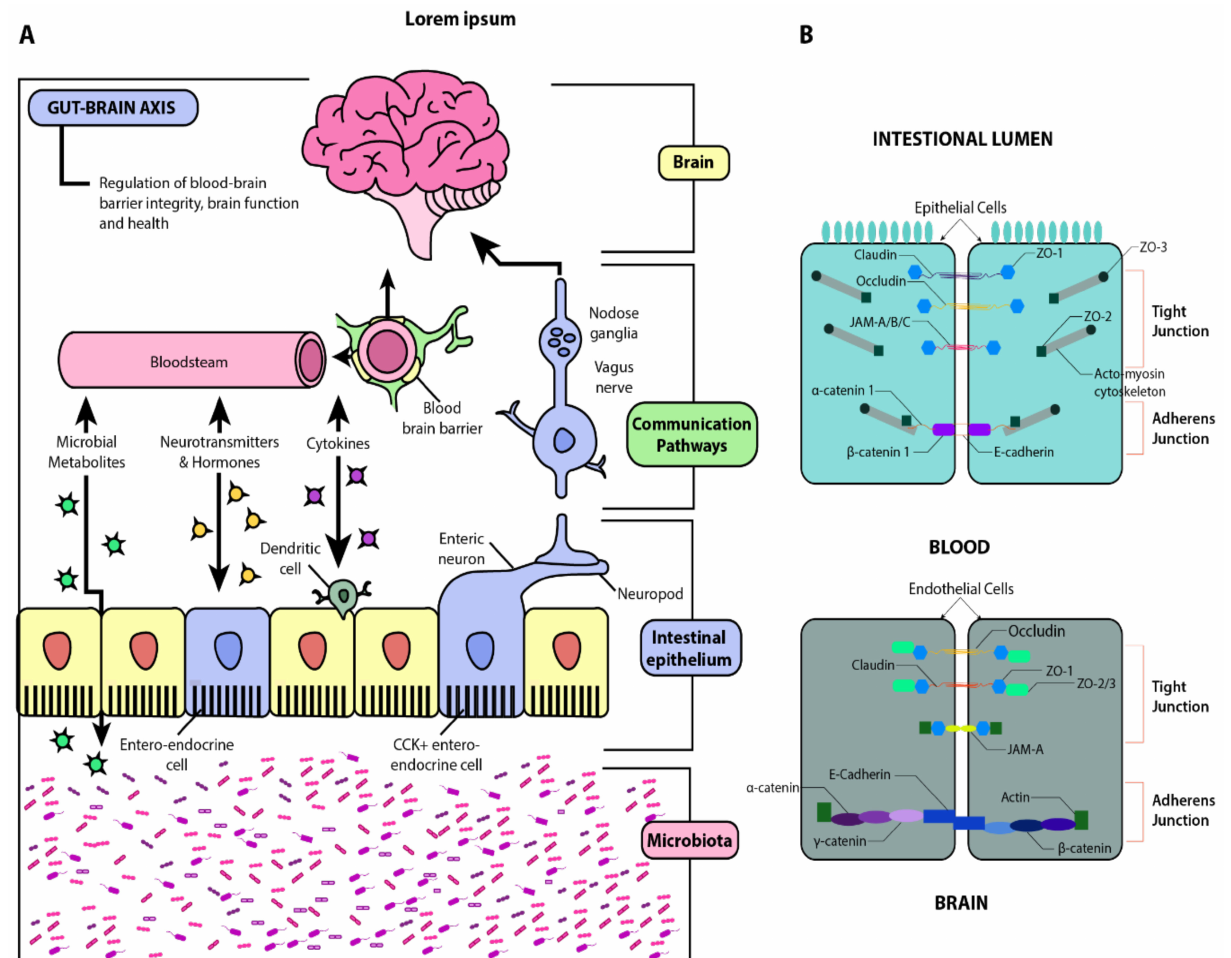
Figure 1. Schematic illustration of the gut-brain axis (GBA). Panel ( A ): Beginning with the microbiota, this diagram illustrates the interactions between the gut and the brain via microbial metabolites, cytokines, neurotransmitters, and hormones. The gut-brain humoral connections which intersect at the blood-brain barrier and the neuronal connections by way of the enteric nervous system and vagus nerve are also illustrated. Through these pathways, dysbiosis and increased barrier permeability may affect neural development, maturation, and function. Panel ( B ): Structural similarities between the blood-brain barrier (BBB) and the intestinal epithelial barrier. Adapted from